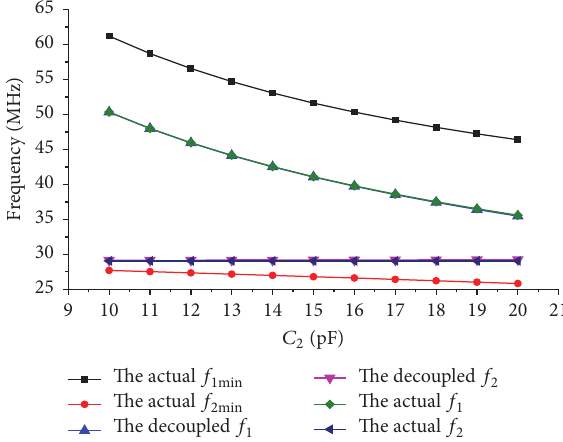
Figure 13: Decoupling theory validation of the